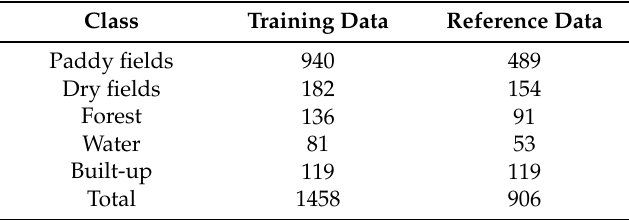
Table 2. The number of training and reference data.